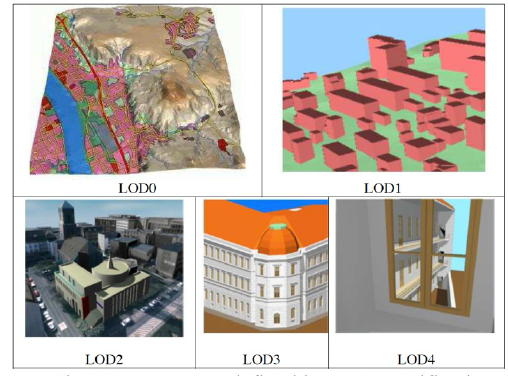
Figure 1 CityGML LODs as defined in OGC